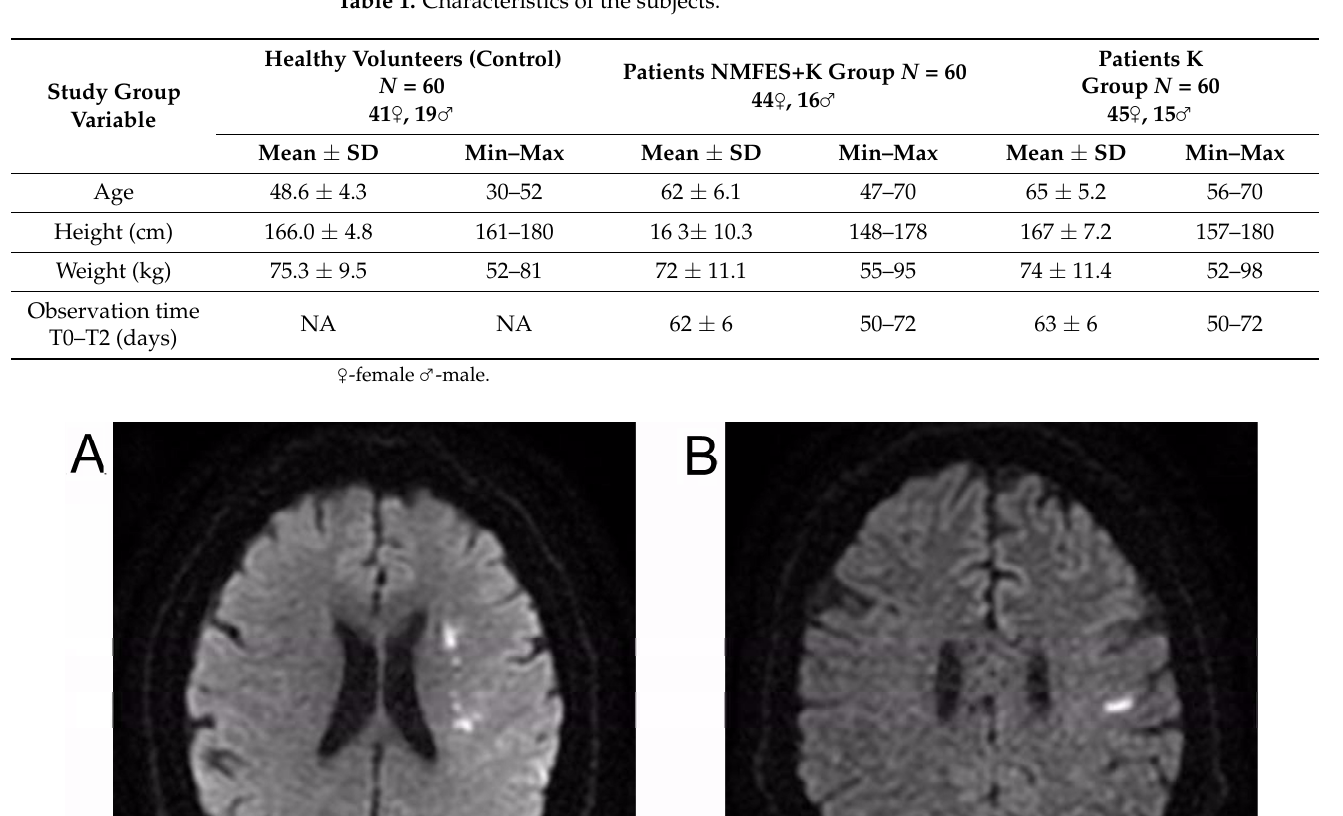
Table 1. Characteristics of the subjects.